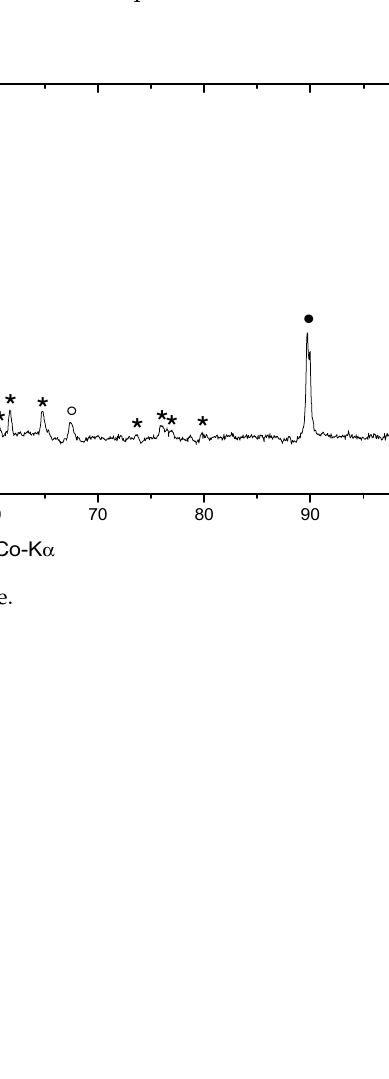
Figure 9. SEM–BSE image of IN738 100R after He exposure showing phases, layers and particles, with the composition identified by